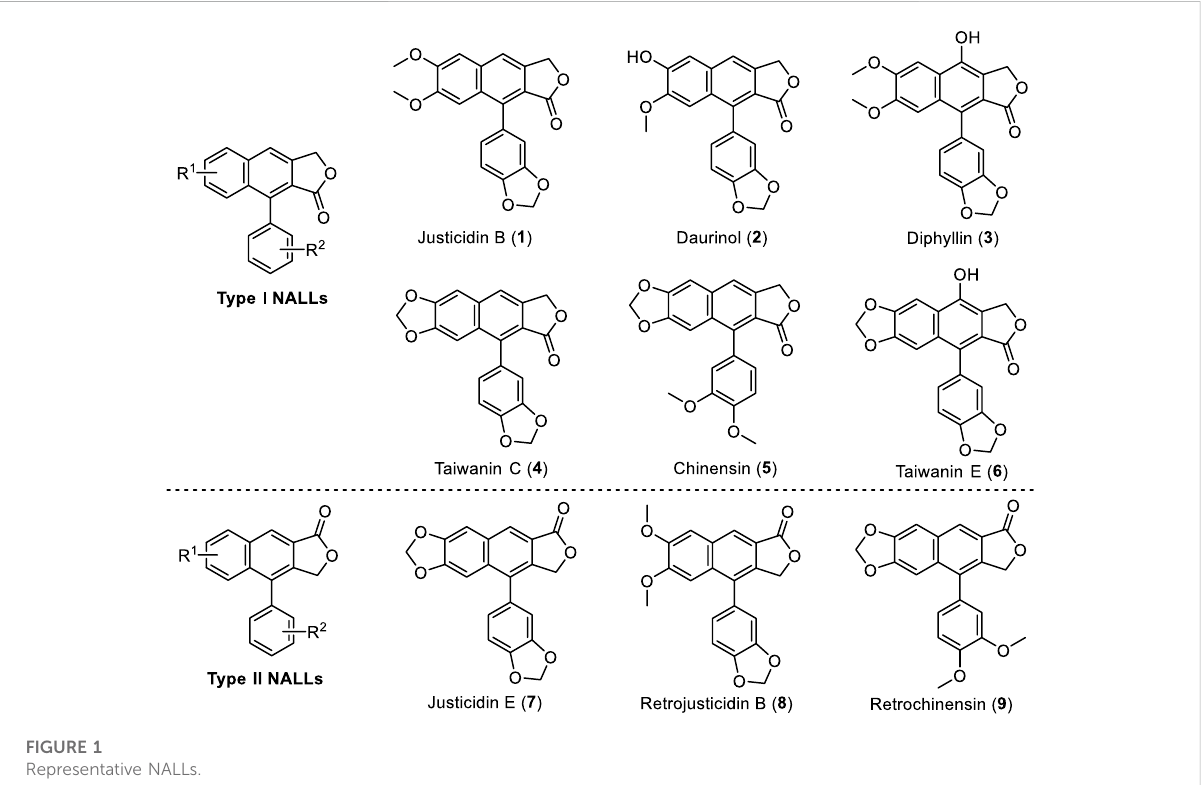
FIGURE 1 Representative